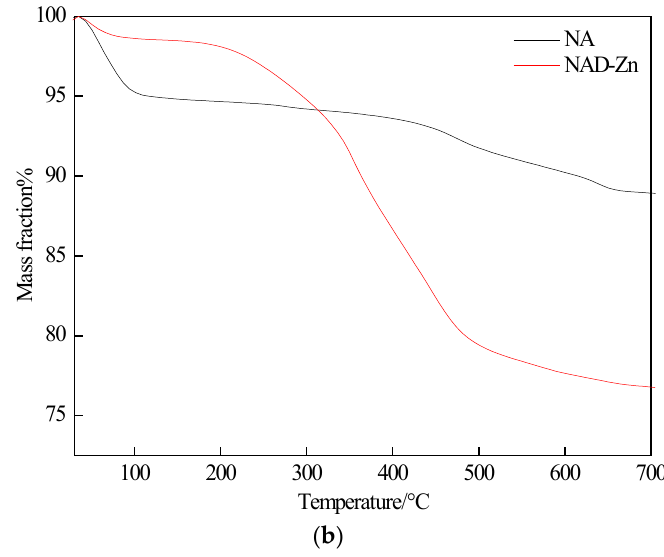
Figure 6. Infrared spectra ( a ) and the TG curve ( b ) of NAD – Zn.